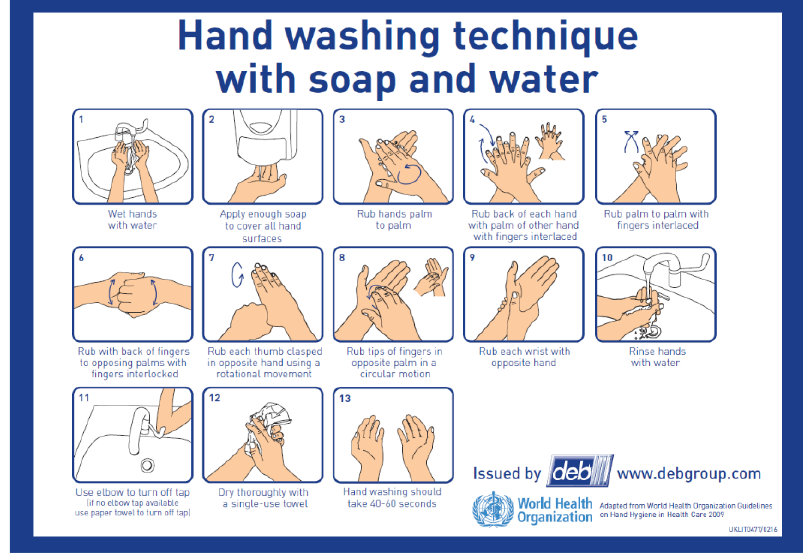
Figure 1. Standard hand-hygiene